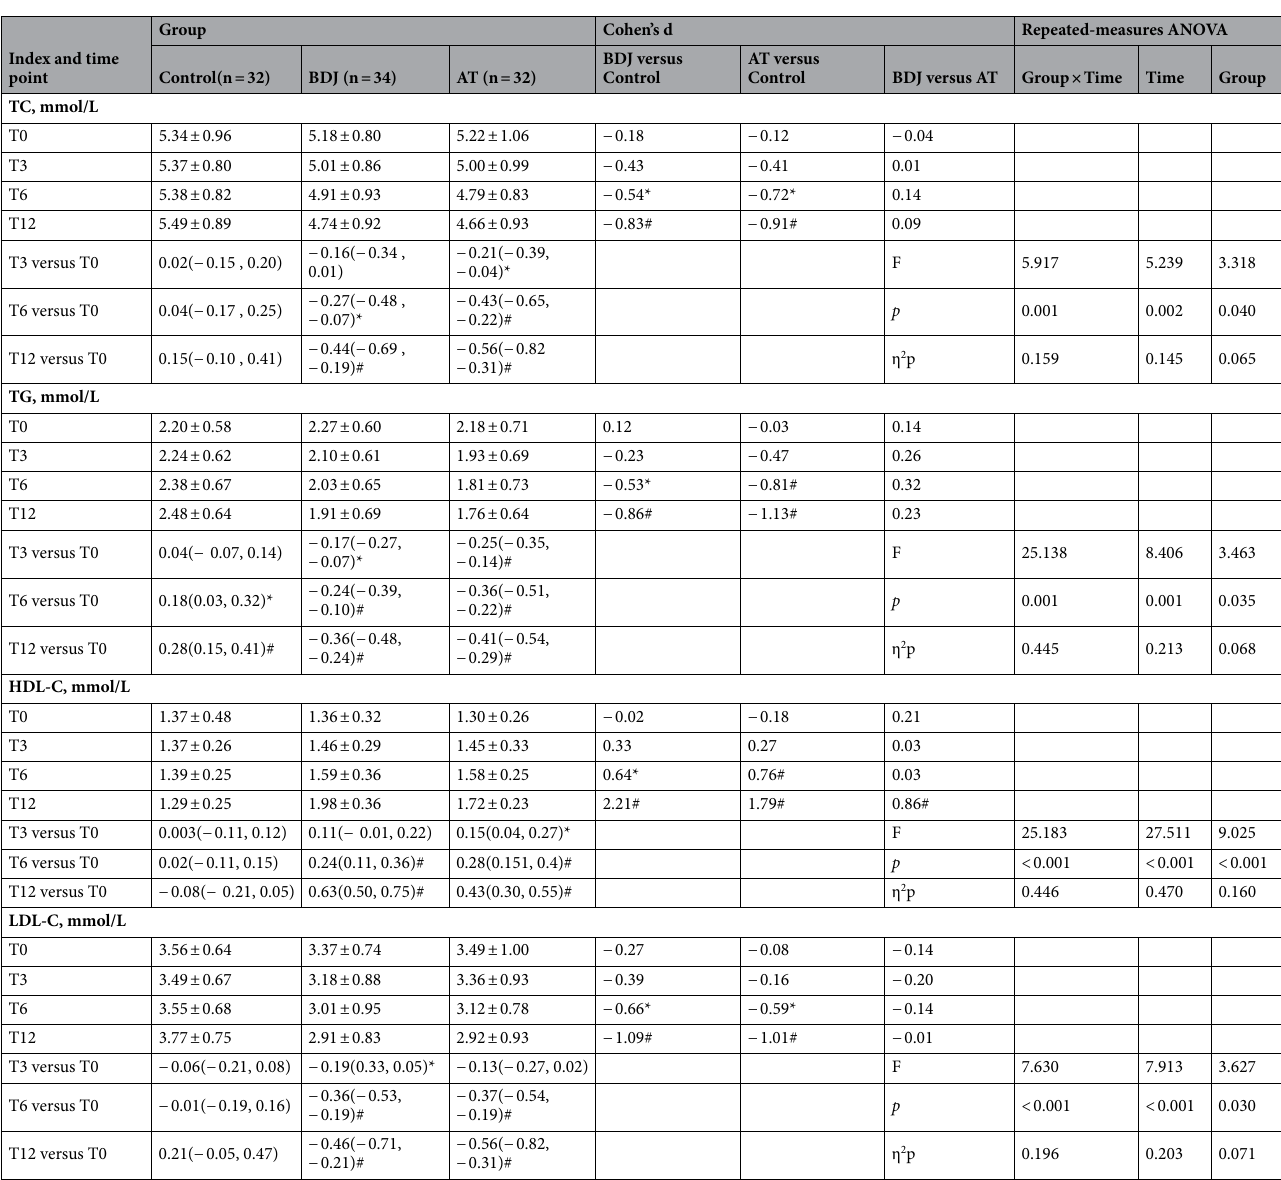
high-density lipoprotein cholesterol; LDL-C, low-density lipoprotein cholesterol; η 2 p, partial eta-squared; T0, baseline; T3, at 3 months; T6, at 6 months; T12, at 12 months; *, significant difference at p < 0.05; #, significant difference at p <